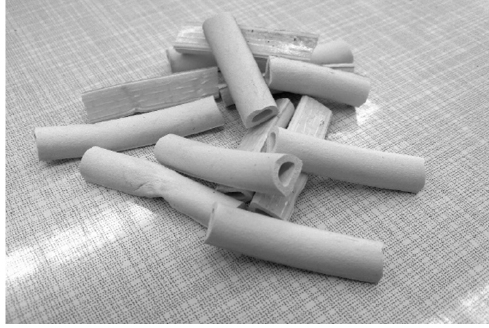
Figure 4. Floating carrier Polyvinyl chloride.